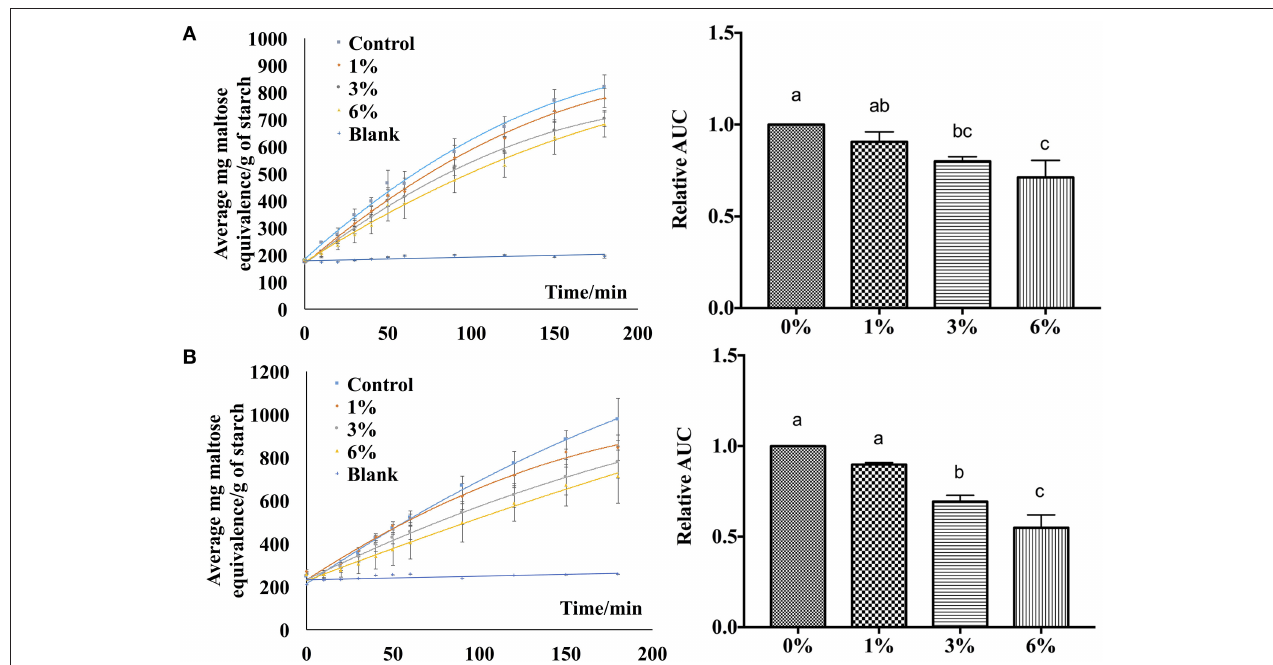
FIGURE 5 | Digestibility profile of (A) wheat noodles and (B) rice noodles. Figures on the left are expressed as mg maltose equivalence/g of starch in flour during in vitro digestibility analysis for 180min while figures on the right are expressed using the area under the curve. a,b,c ANOVA ( n = 3) at 95% confidence level with same letters indicating no significant difference in area under the curve (AUC) at different concentrations.